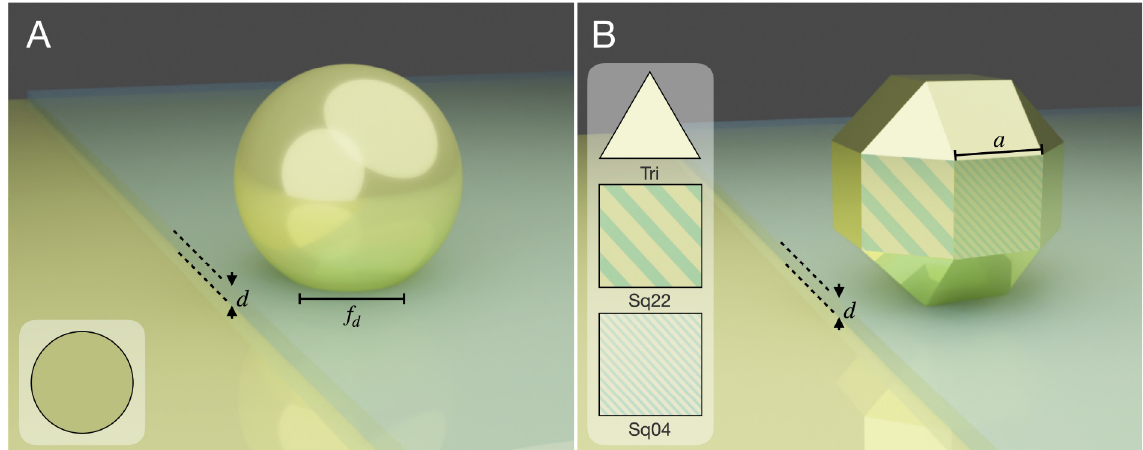
Fig. 1. Nanoparticle-on-mirror schematics for gold NPs assembled d =1nm above a gold substrate, separated by a spacer of refractive index n =1.45. A. Faceted spherical NPoM geometry for a 2 r p = 80nm NP with a facet diameter of f d =20 nm. The inset shows the circular facet that is in contact with the spacer. B. RhoM geometry for a NP with side length a = 30nm and facet edge rounding r = 5nm. The inset shows the three unique facets that may be assembled on the